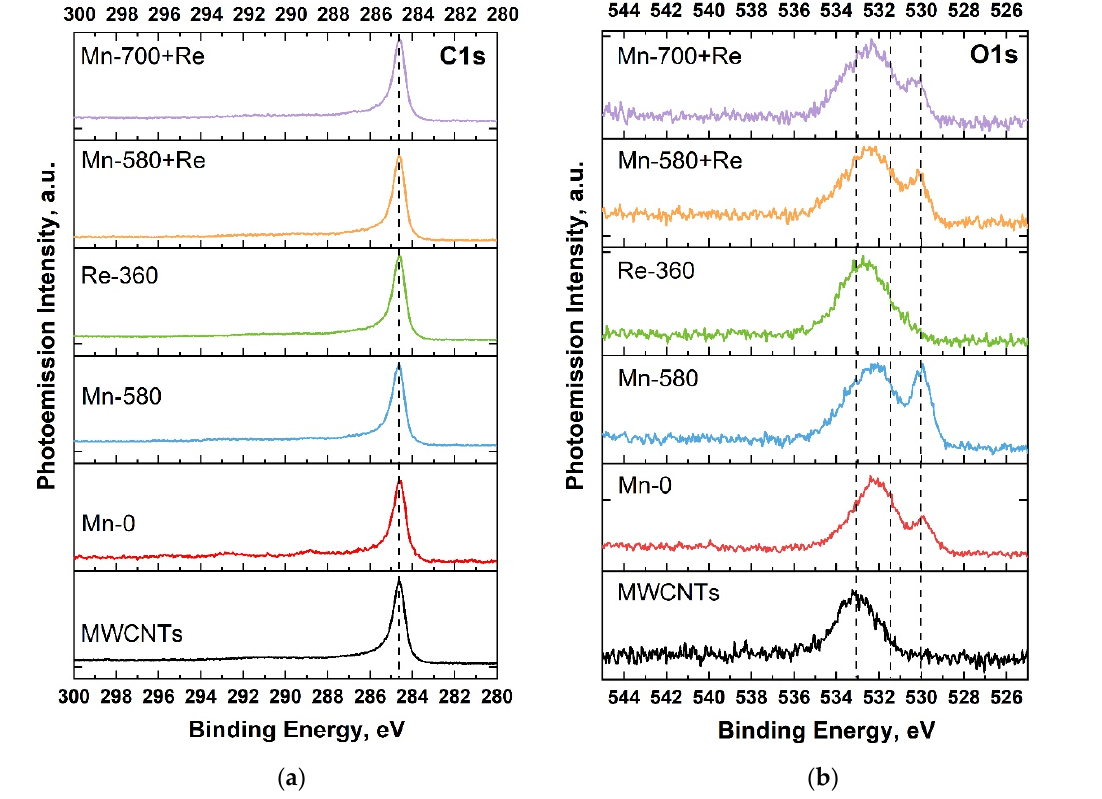
Figure 3. C1s ( a ) and O1s ( b ) PE spectra of MWCNTs and composites.